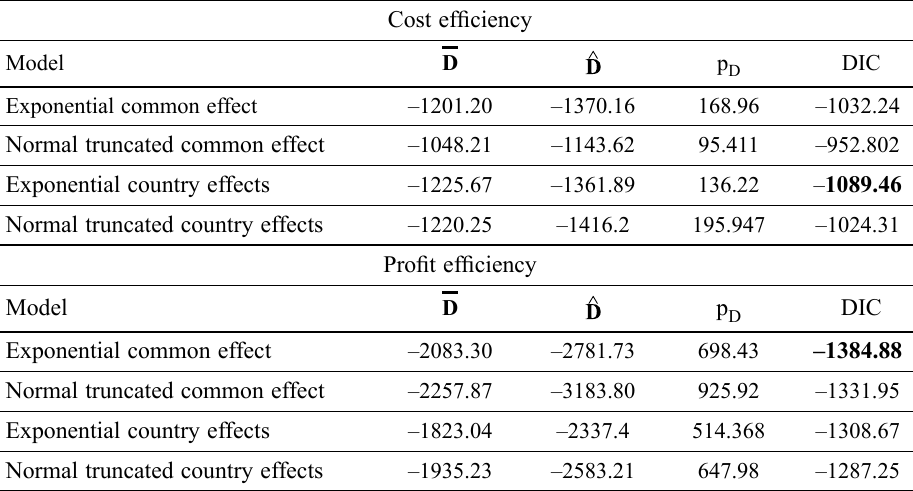
Table 5. Comparison of the models that use the date of the bank’s country incorporation into the EU as explanatory variable of the inefficiency term distribution (in bold signalled the model with the best goodness of fit to data according to DIC